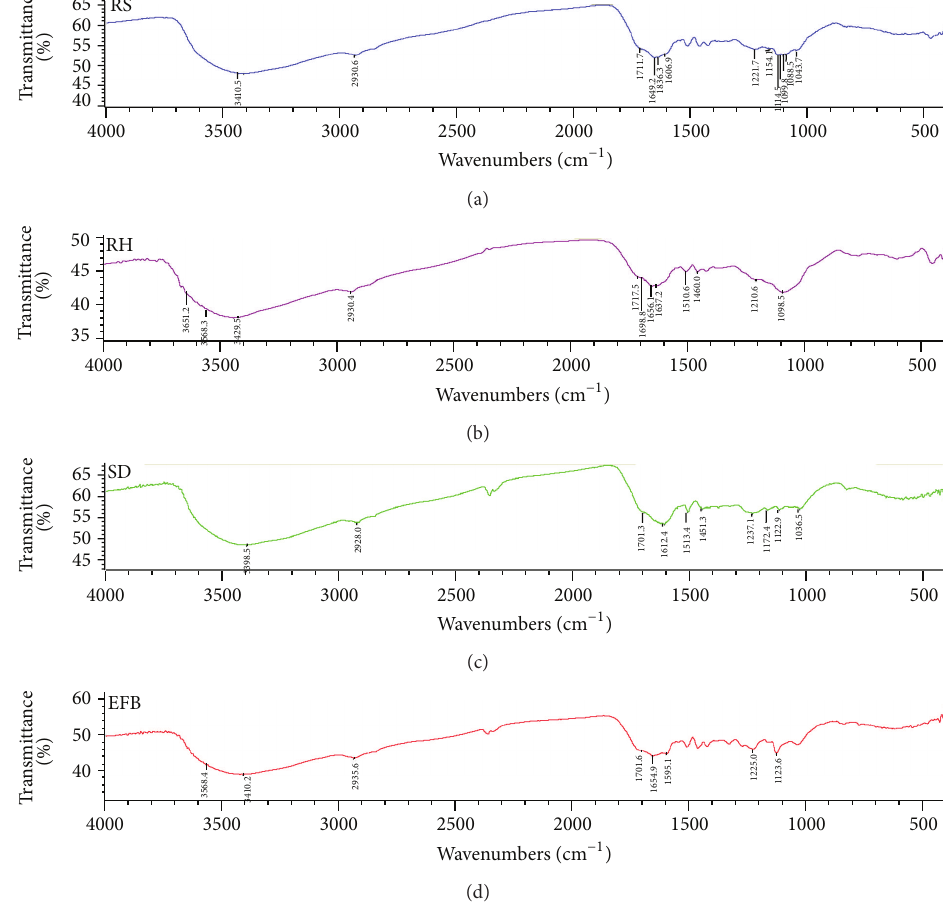
Figure 2: Fourier transform infrared (FTIR) spectra of HA from rice straw, rice husk, sawdust, and oil palm empty fruit bunch. ratios compared to other composts. Sawdust compost